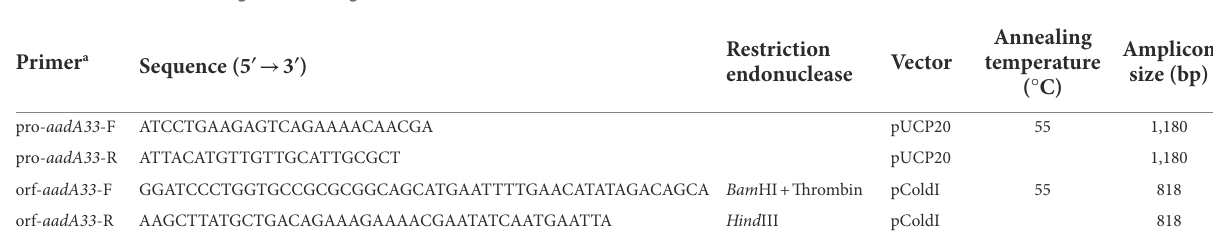
TABLE 3 Primers for cloning the aadA33